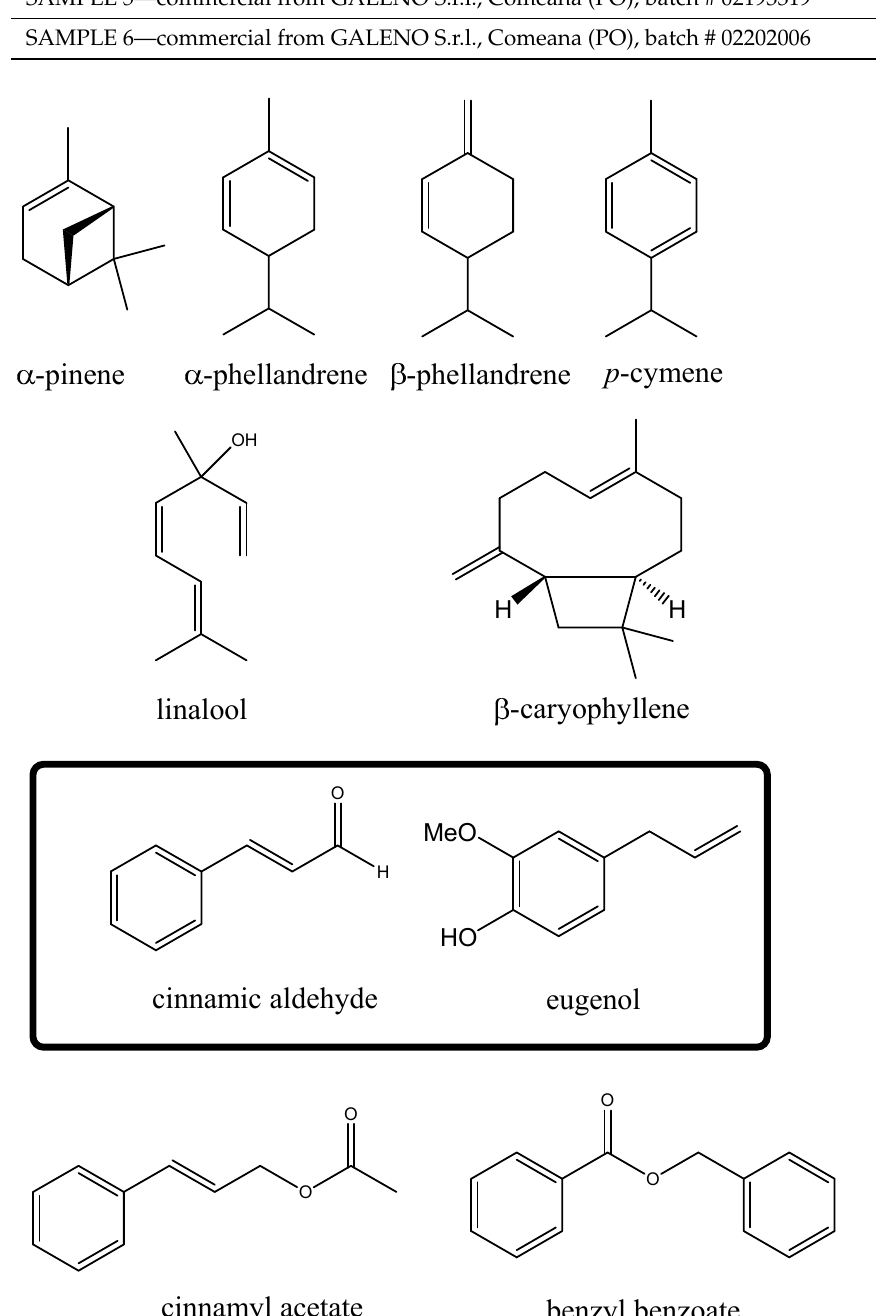
Figure 1. Molecular formula of the main components of cinnamon essential oils.